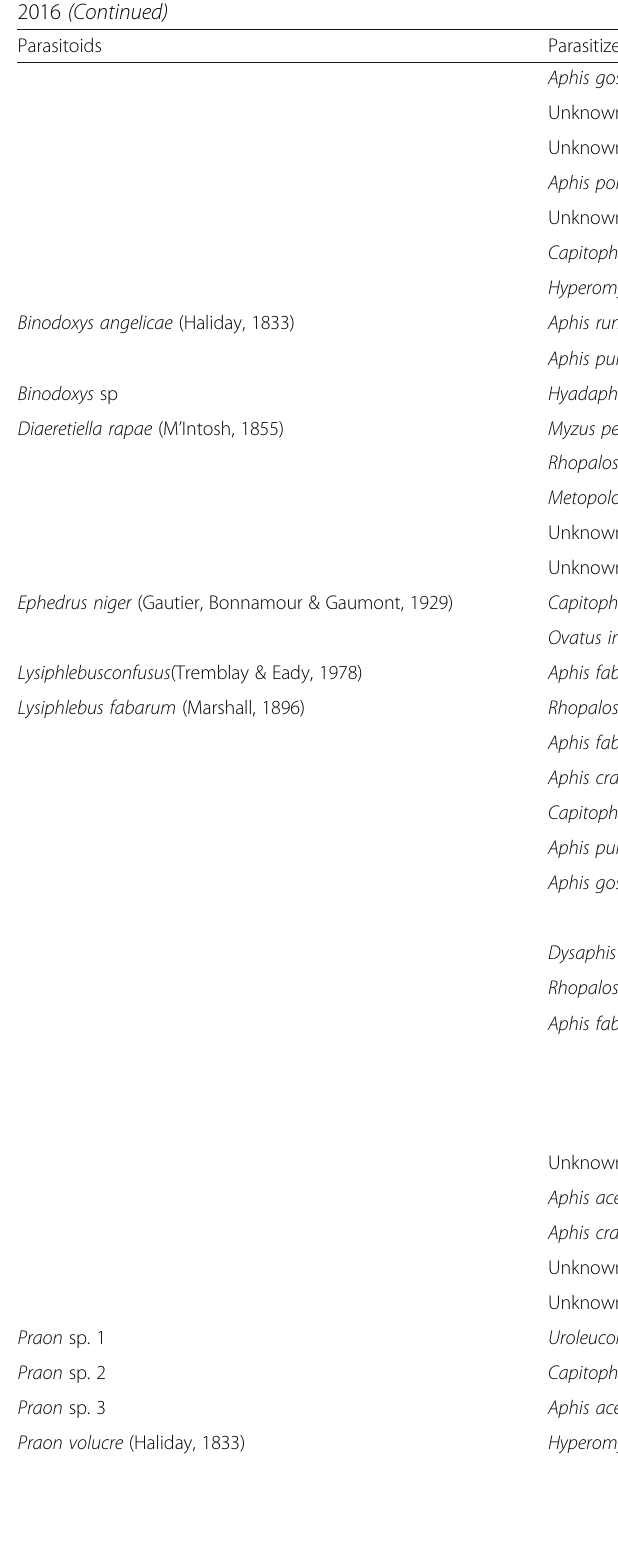
Table 1 Tri-trophic associations, plant-aphid-parasitoid, noted at the oasis ecosystems in the region of Biskra between 2014 and 2016